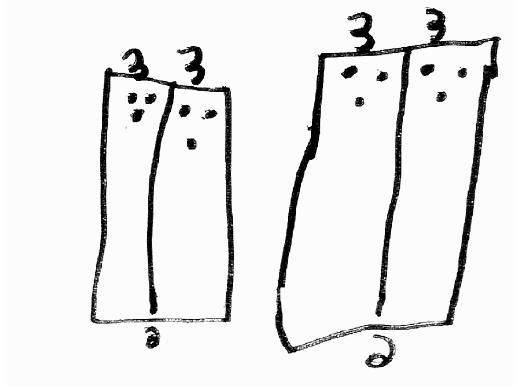
Figura 9 . As quatro e as duas partes para 12(cid:247)4.